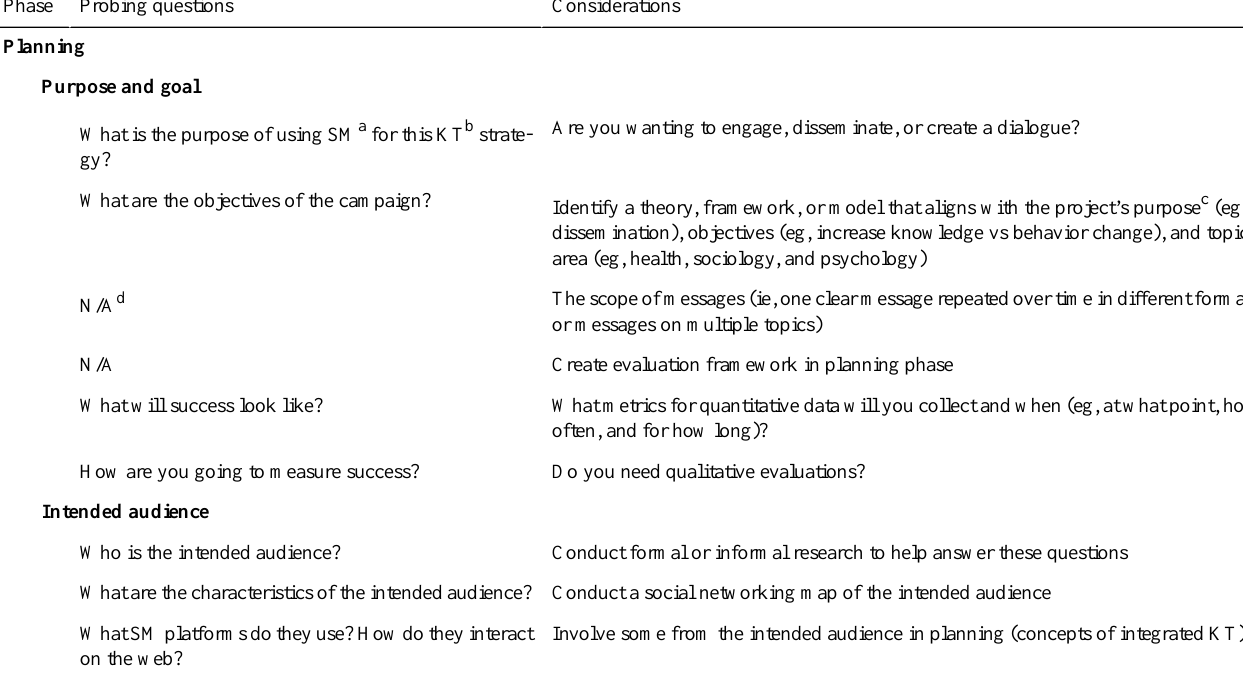
Table 2. Checklist for researchers: what to ask and consider when developing a social media knowledge translation